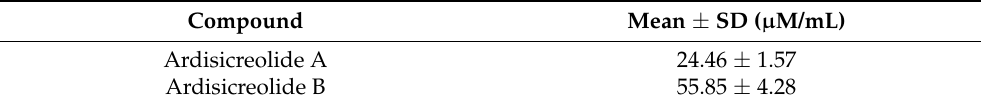
Table 3. The IC 50 values of Ardisicreolides A and B as inhibitors of LPS-treated RAW264.7